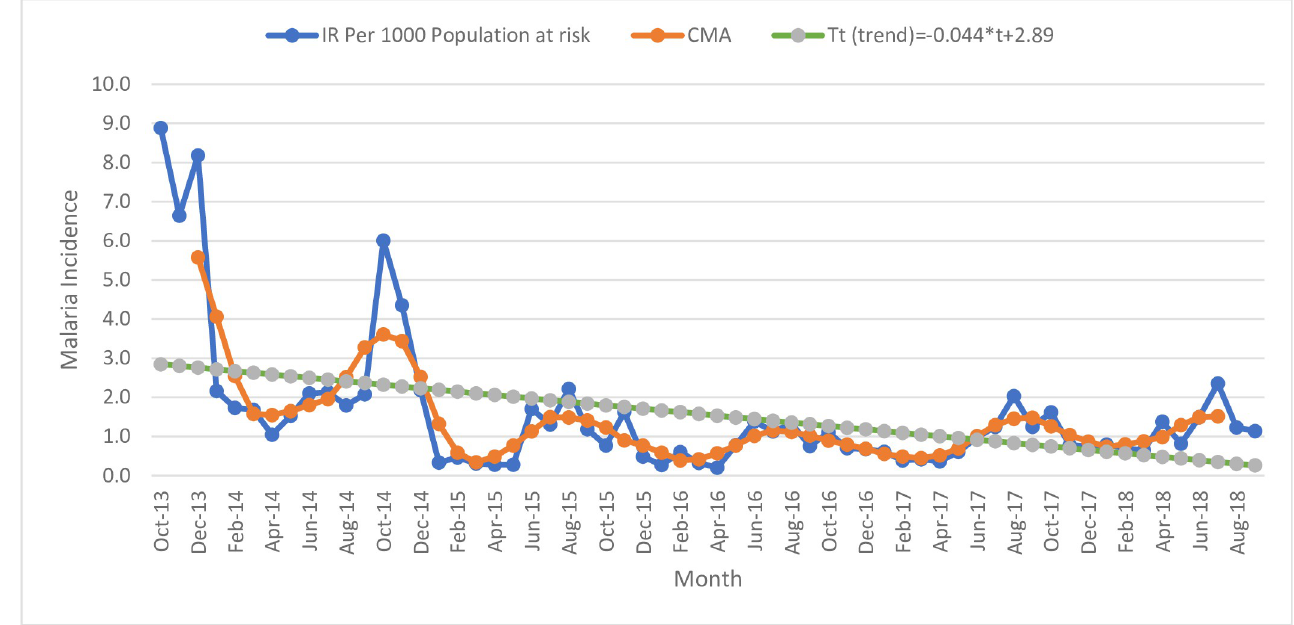
Fig 2. Seasonal decomposition of malaria incidence per 1000 population at risk between September 2013 and 2018 in the intervention kebeles.